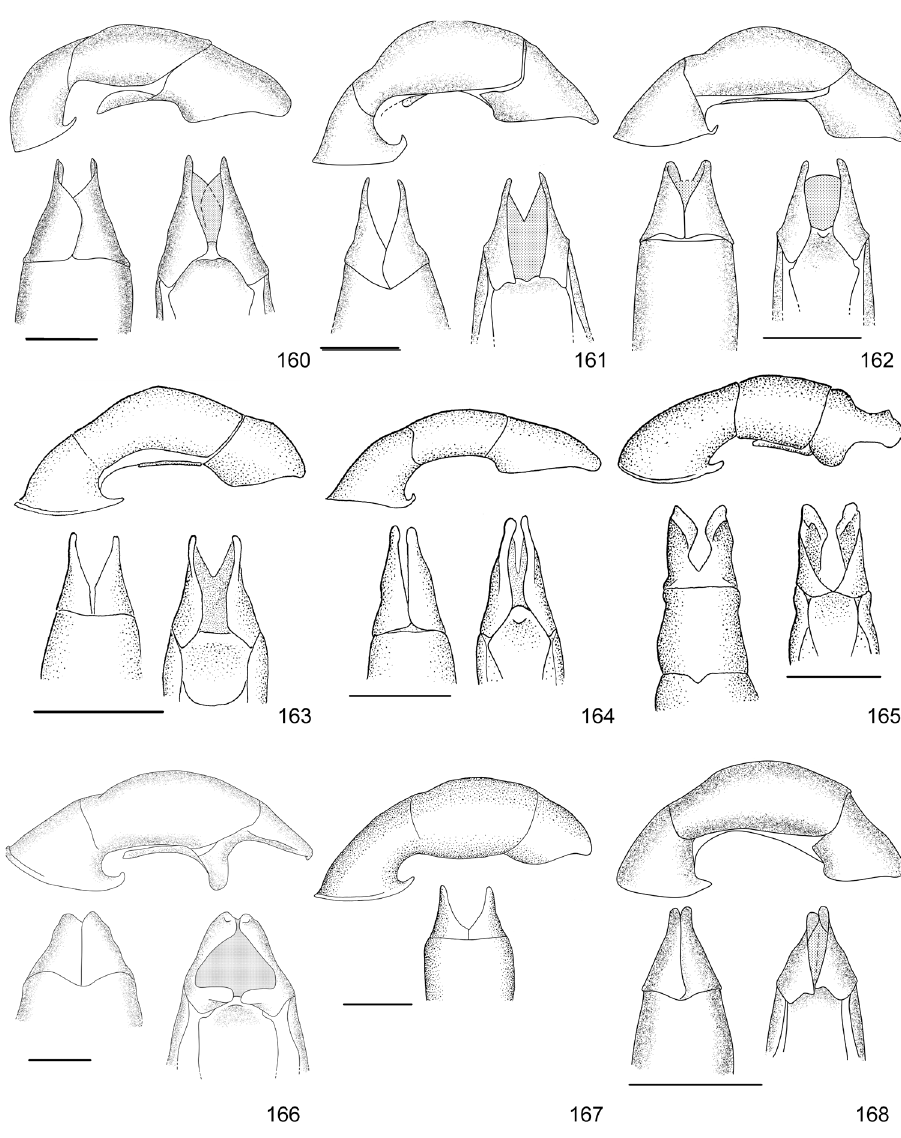
Figures 160–168. Shape of aedeagus, lateral view (top), dorsal view (bottom left), ventral view (bot- tom right). 160 Anomala obovata (Quebrada Kuisa, Limón, MNCR) 161 ochrogastra (Finca Cafrosa, Puntarenas, MNCR) 162 A. ochroptera (La Maritza, Guanacaste, MNCR) 163 A. parvaeucoma (Estación Sirena, Puntarenas, MNCR) 164 A. perspicax (La Esperanza, Cartago, CEUA) 165 A. piccolina